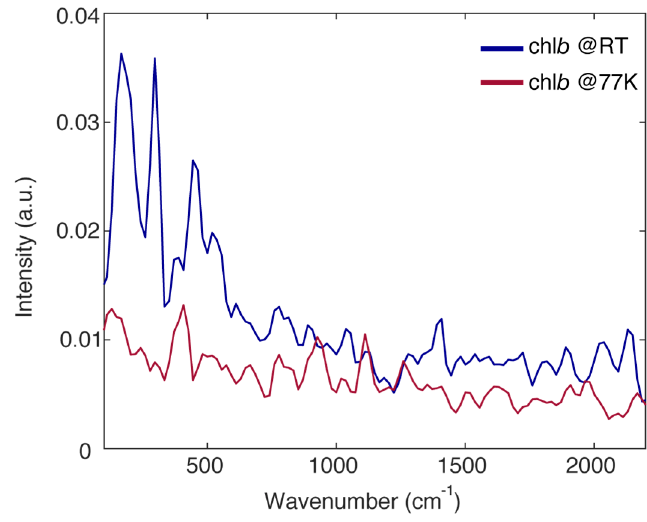
Figure 5. Fourier spectra of coherences obtained from the analysis of the purely absorptive 2DES maps of chl b at RT (blue) and at 77 K (red). Before calculating the residues, the 2DES response has been normalized on its maximum in order to allow a comparison between the amplitudes of the beatings in the two sets of measurements.